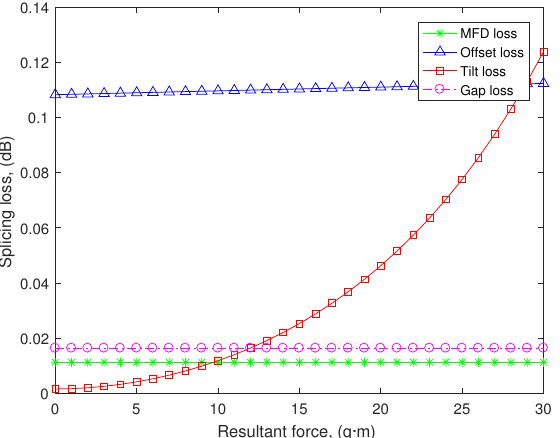
Figure 4. Splice loss versus resultant force, the four fusion variables affected by the resultant force have an impact on the splice loss of two kinds of optical fibers. In high altitude environment, the resultant force includes surface tension, the force exerted by the fusion splicer, atmospheric pressure, gravity force, the thermal expansion force and glass viscosity force, and increases in steps size of 1 g · m, as shown in the abscissa of the